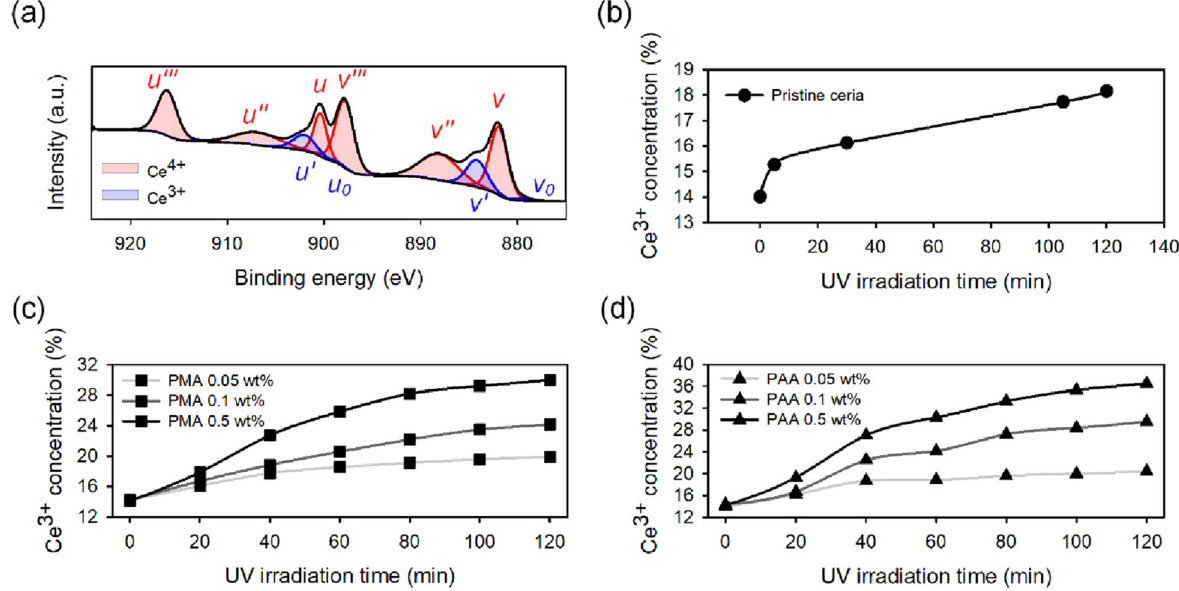
Figure 3. ( a ) XPS spectra of the Ce 3 d peaks of the CeO 2 and an increase in the concentration of Ce 3+ ions according to ( b ) UV irradiation and photo-oxidative degradation of ( c ) PMA and ( d ) PAA at different